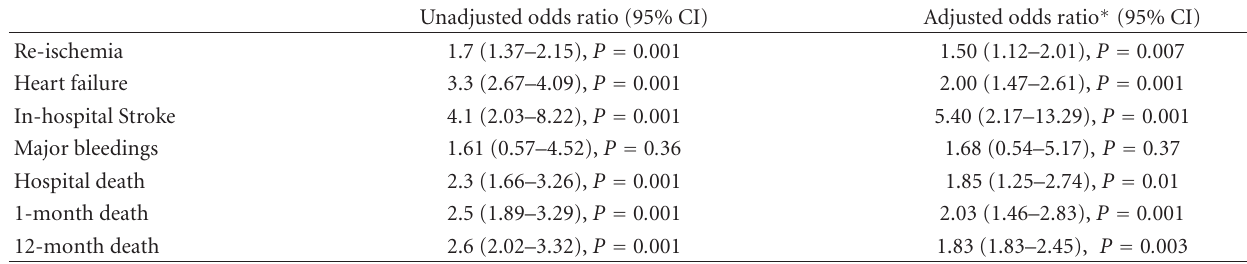
Table 4: Multivariate logistic regression analysis for predictors of clinical outcomes in patients with polyvascular disease presenting with acute coronary syndrome.